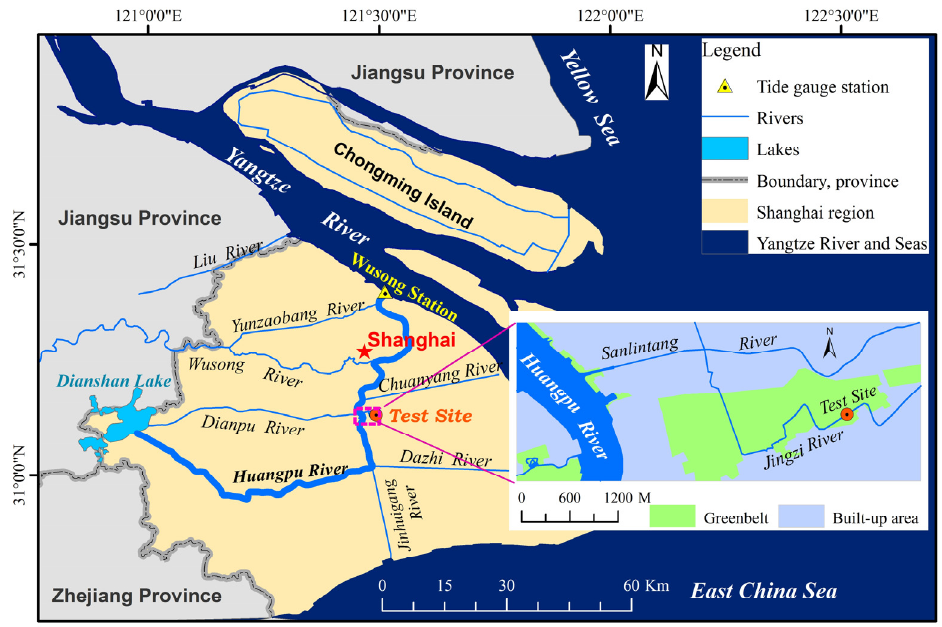
Figure 1. Location of the test site.